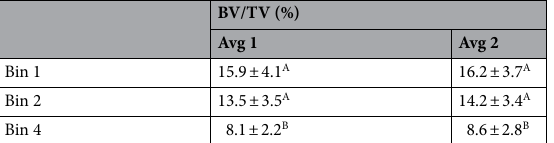
Table 3. Mean and standard deviation of BV/TV values, according to frame averaging (Avg 1 or Avg 2) and data binning (Bin 1, Bin2, and Bin 4). Different uppercase letters among the rows in a column indicate significant differences; Bonferroni post-hoc test (p < 0.05).